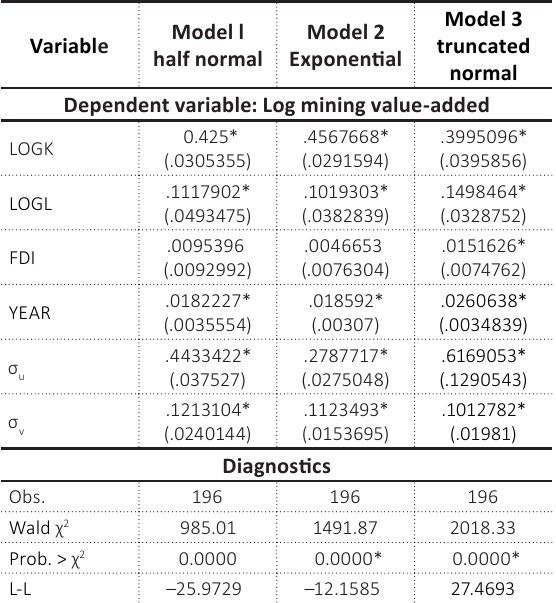
Table 5. Cobb-Douglas Stochastic Frontier true fixed effects – maximum likelihood estimates